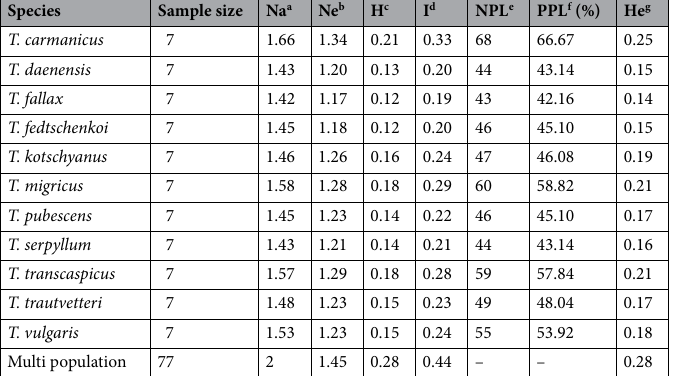
Table 8. Summary of genetic variation statistics for SRAP markers used in Thymus species. a Observed number of alleles. b Effective number of alleles. c Gene diversity. d Shannon’s information index. e Number of polymorphic loci. f Percentage of polymorphic loci. g Expected